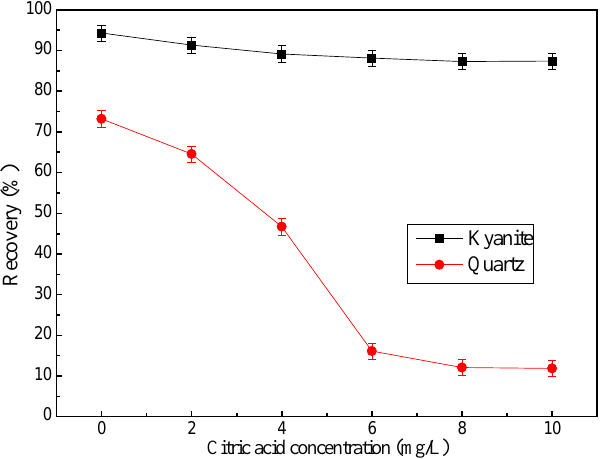
Figure 4. Effect of citric acid concentration on flotation behavior of single